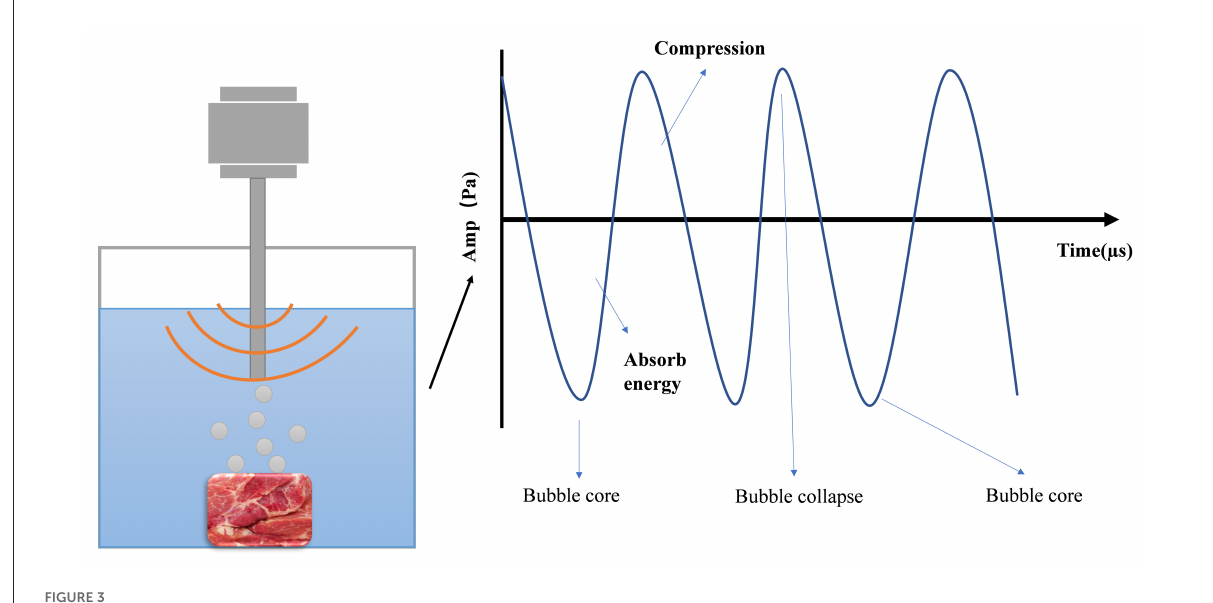
FIGURE3 Mechanism of ultrasound-assisted